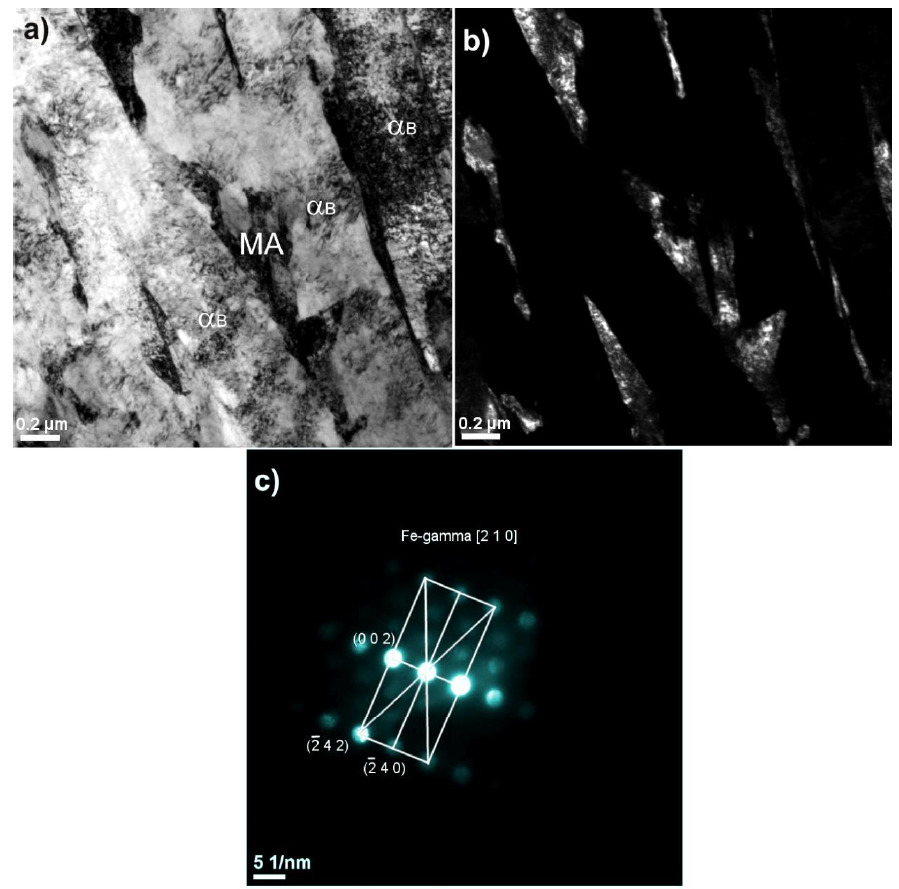
Figure 3. Retained austenite layers located between bainitic ferrite laths in 5Mn-1.5Al steel ( a ) bright field, ( b ) dark field from (002)Fe γ , ( c ) microdiffraction solution from the middle of the austenite lath; α B — bainitic ferrite, MA — martensite-austenite constituent.